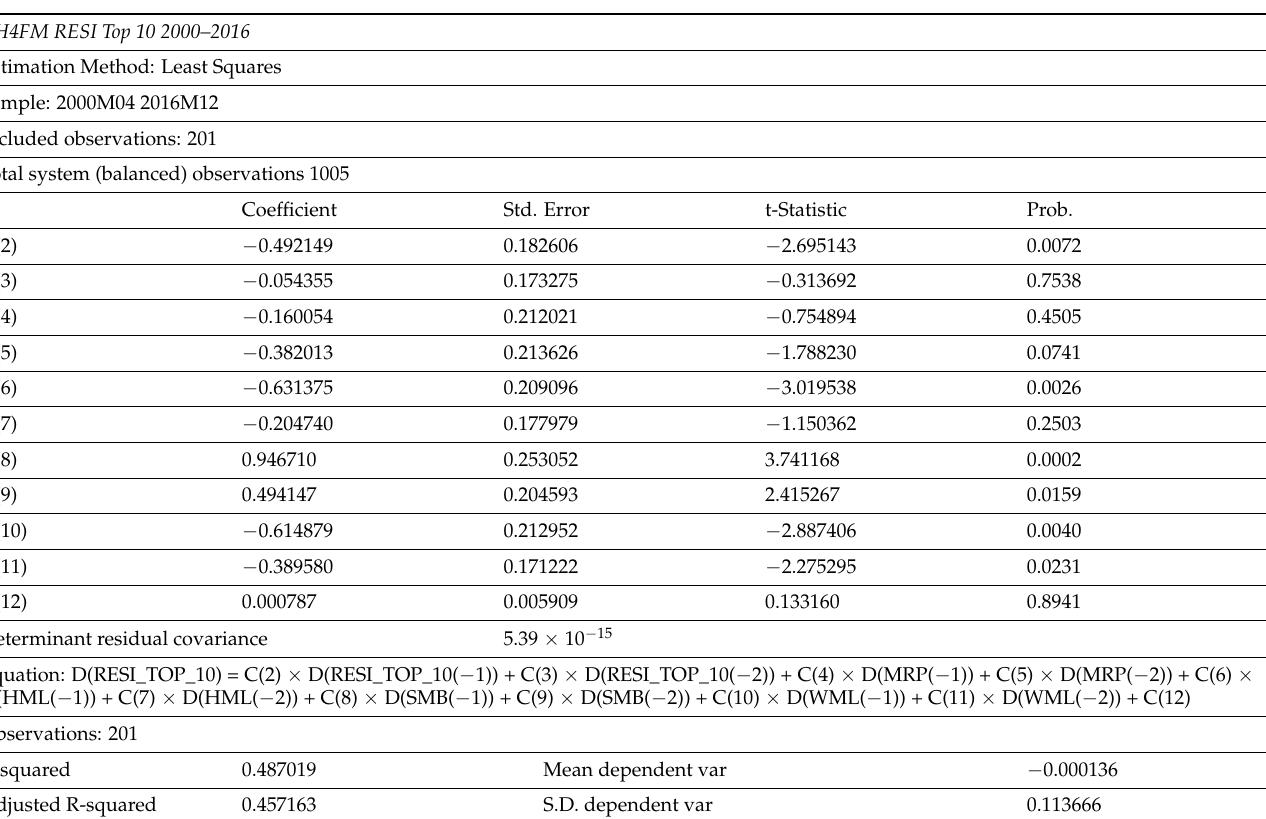
Table 7. Carhart four-factor